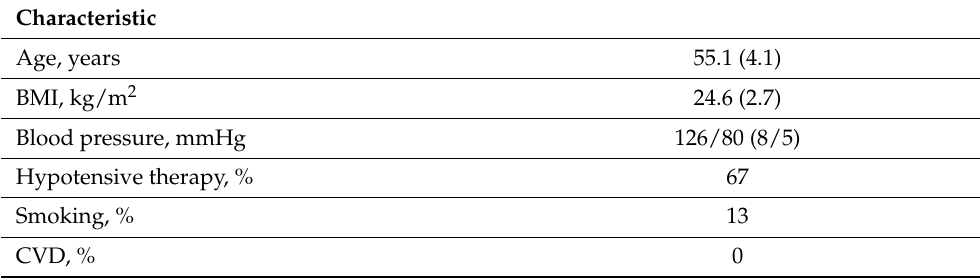
Table 1. Clinical characteristics of participants of the study on the effect of licorice root powder on serum